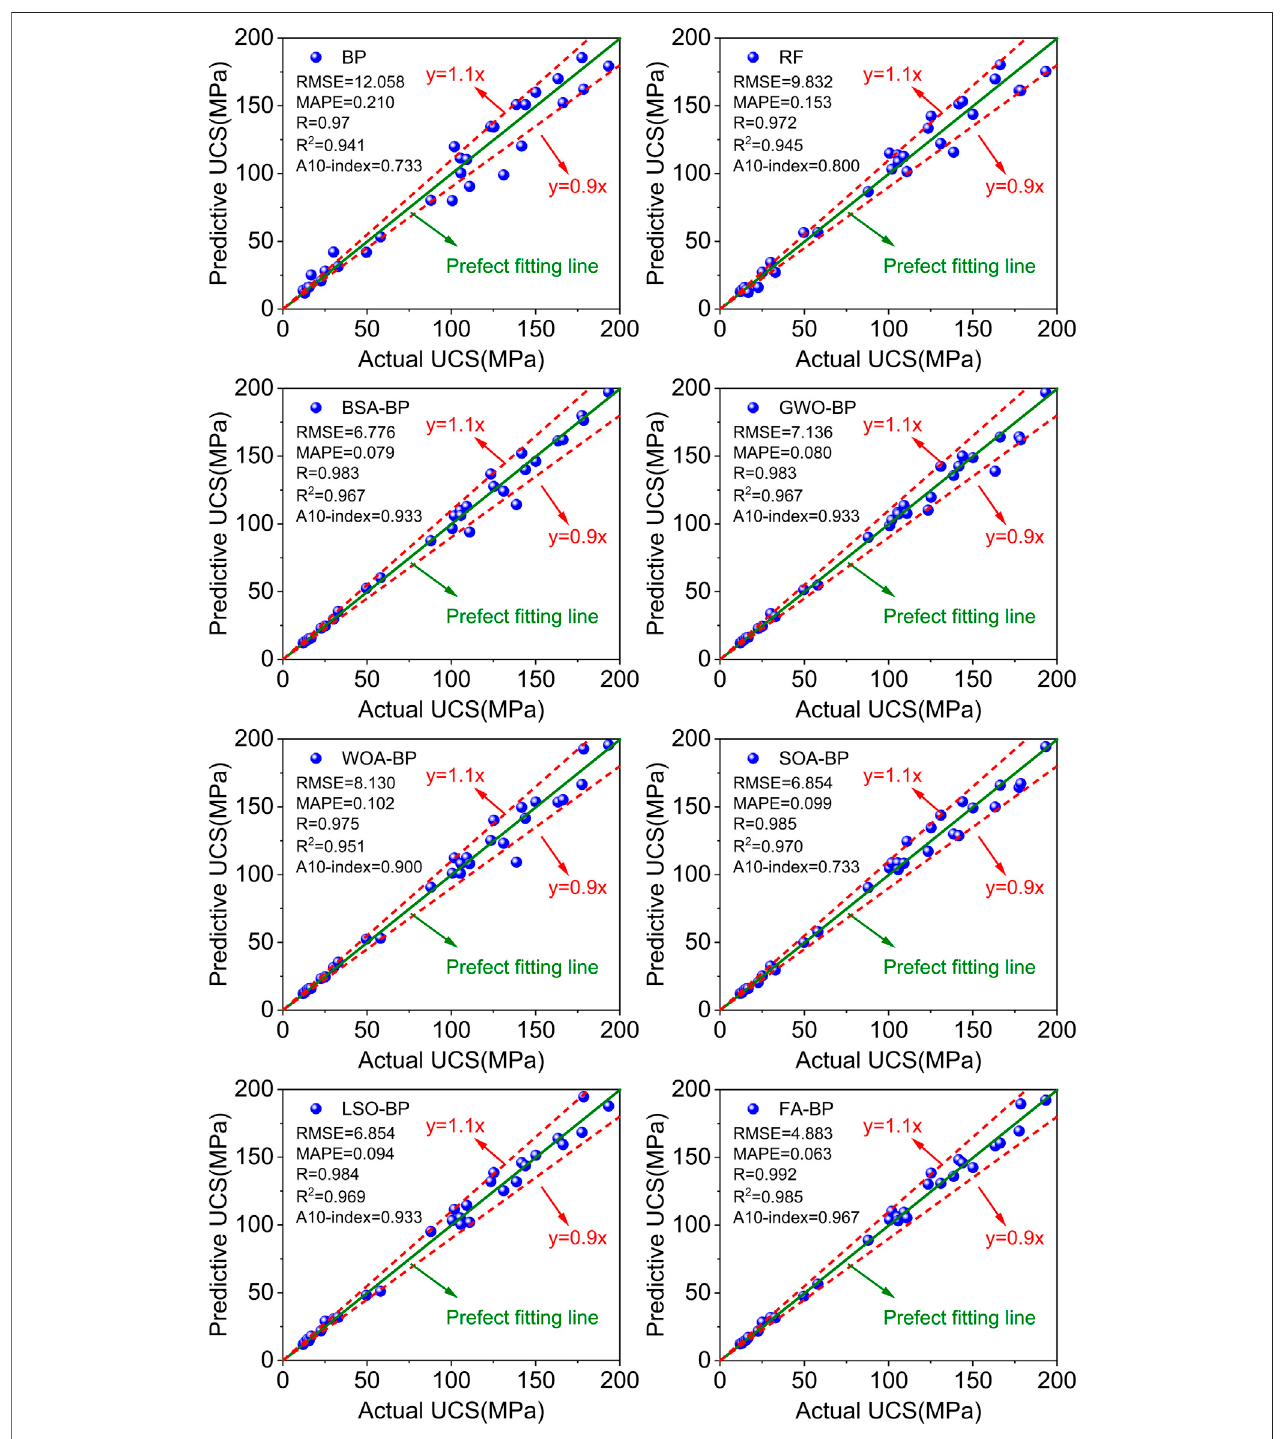
FIGURE 8 | Correlation analysis between predicted and actual